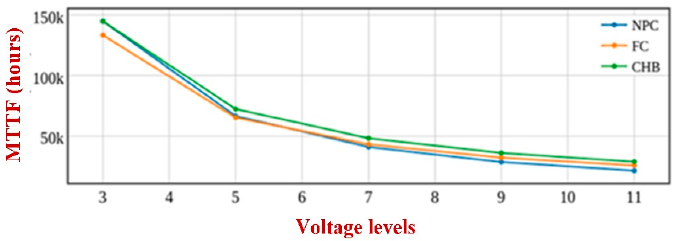
Figure 21. The approximate MTTF for different voltage levels.